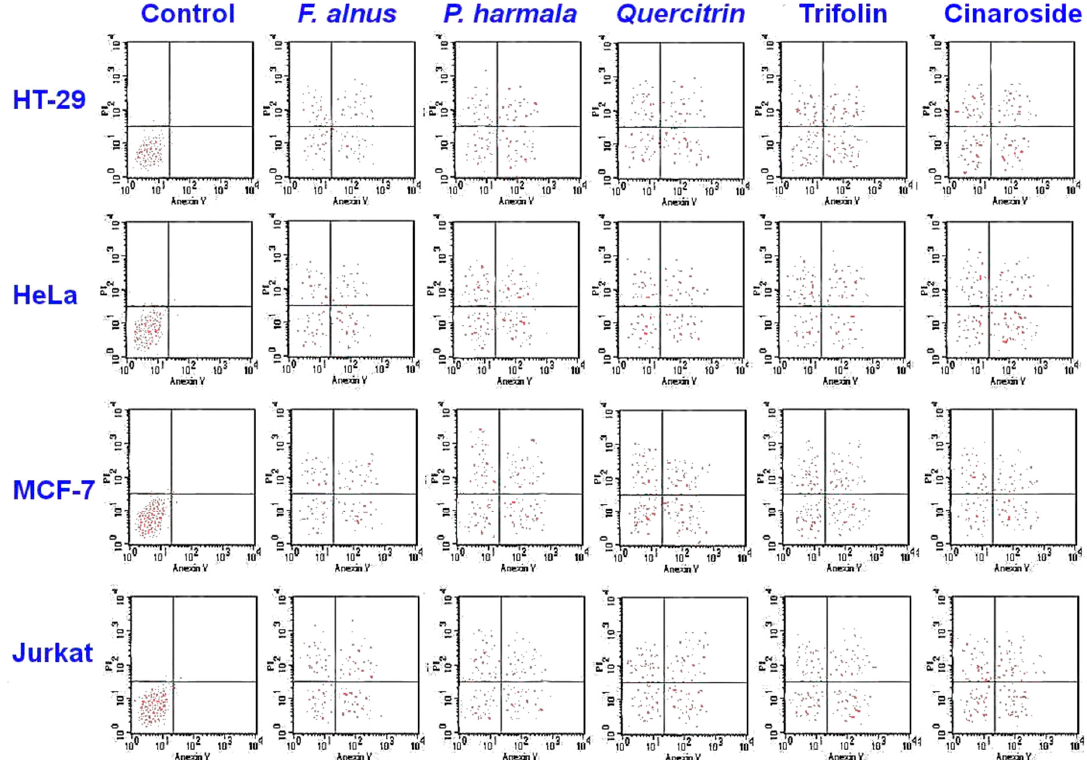
Figure 3. Cytotoxicity of F. alnus and P. harmala methanolic extracts, quercitrin, trifolin, and cynaroside, as estimated by flow cytometry. Lower left, viable cells; upper left, necrotic cells; lower right, early apoptotic cells and upper right, late apoptotic cells. Flow cytometry showed obvious apoptotic cell accumulation following 48 h of exposure in the upper and lower right quadrant.